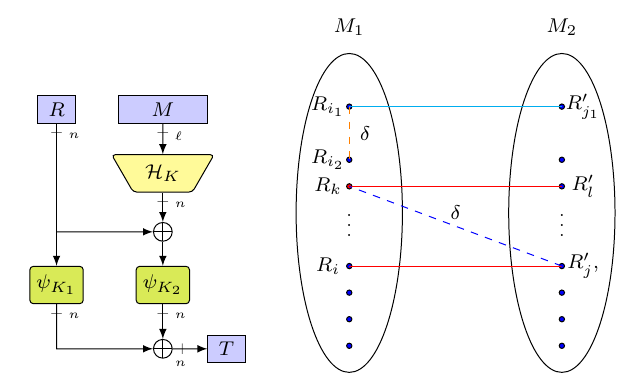
Figure 4.1: Forgery on EHtM ; Guessing the hash difference in the lower part which is depicted through solid red line and dashed blue line. Forging attempt in the upper part which is depicted through solid cyan line and dashed orange line. If R